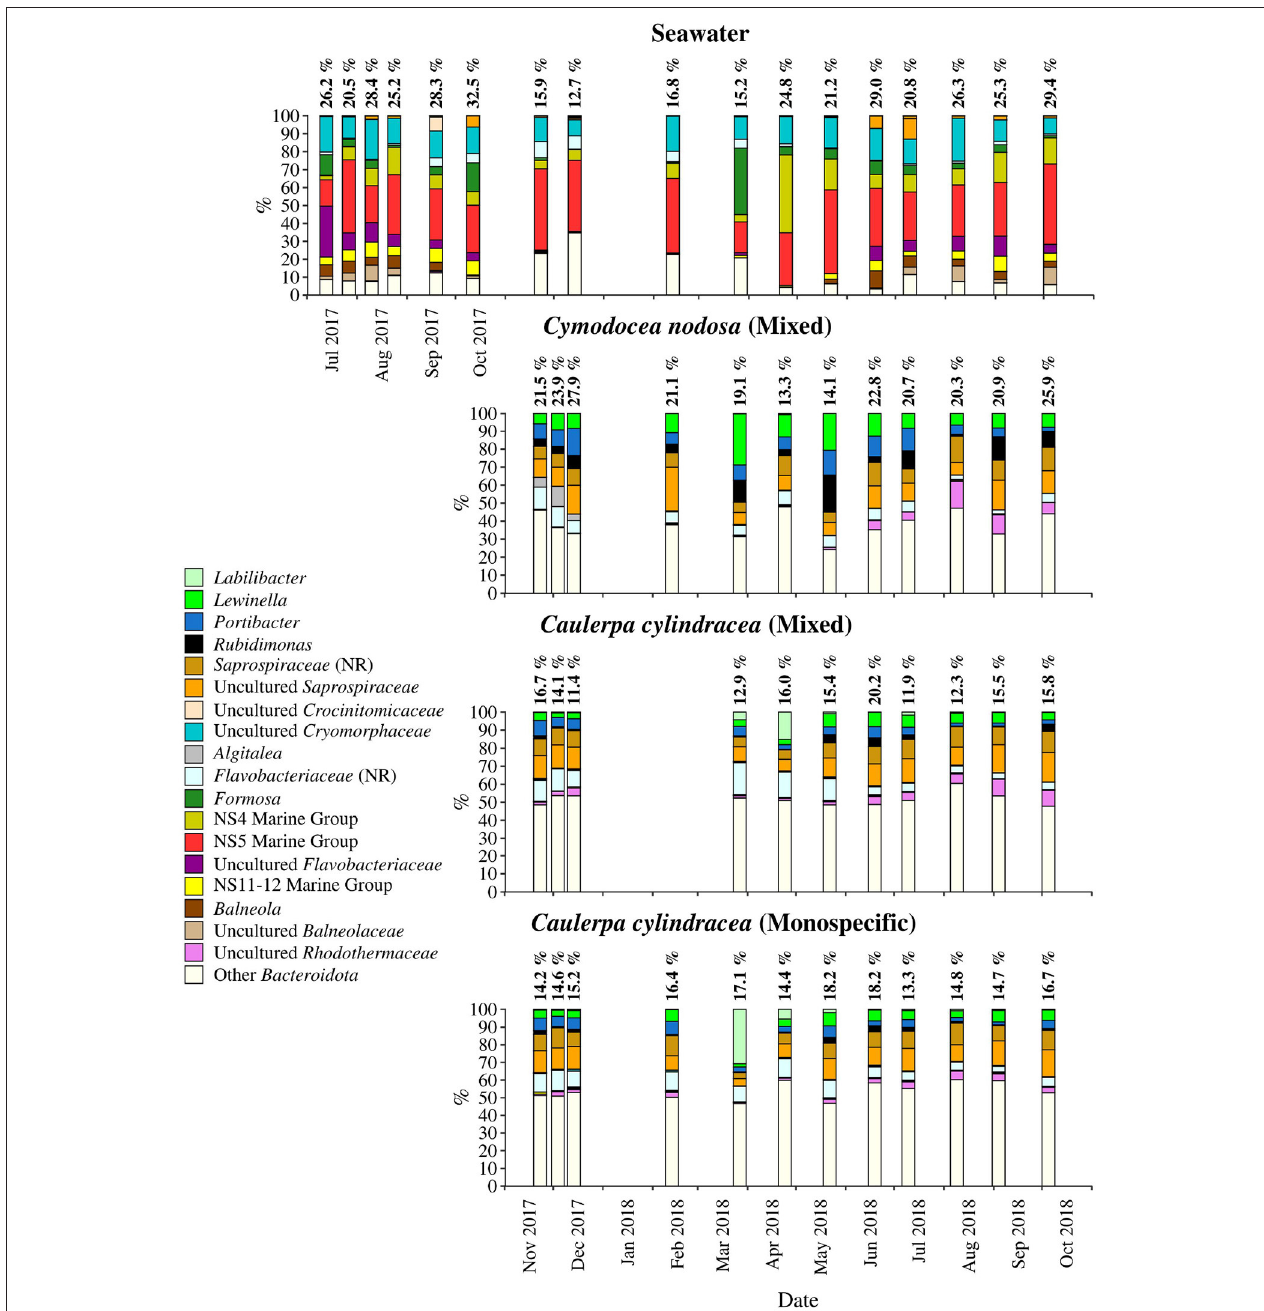
FIGURE 6 | Taxonomic classification and relative contribution of the most abundant ( ≥ 2%) sequences within the Bacteroidota on the surfaces of the macrophytes C. nodosa (mixed settlement) and C. cylindracea (mixed and monospecific settlement) and in the ambient seawater. The proportion of sequences classified as Bacteroidota in the total bacterial and archaeal community is given above the corresponding bar. NR – No Relative (sequences without known relatives within the corresponding group).